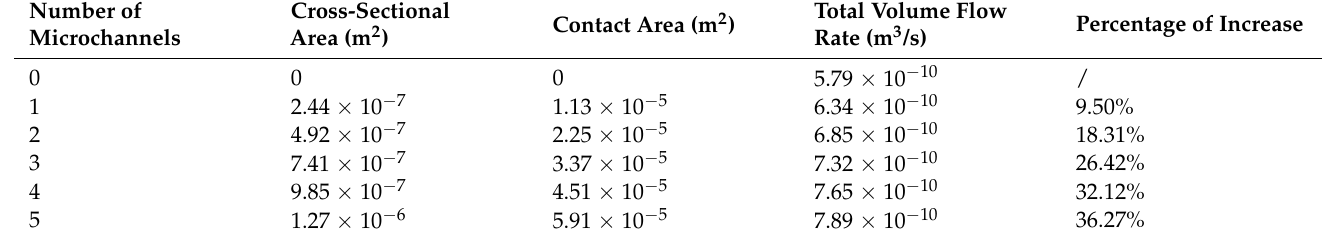
Table 10. Effects of the number of microchannels on the volume flow rate.